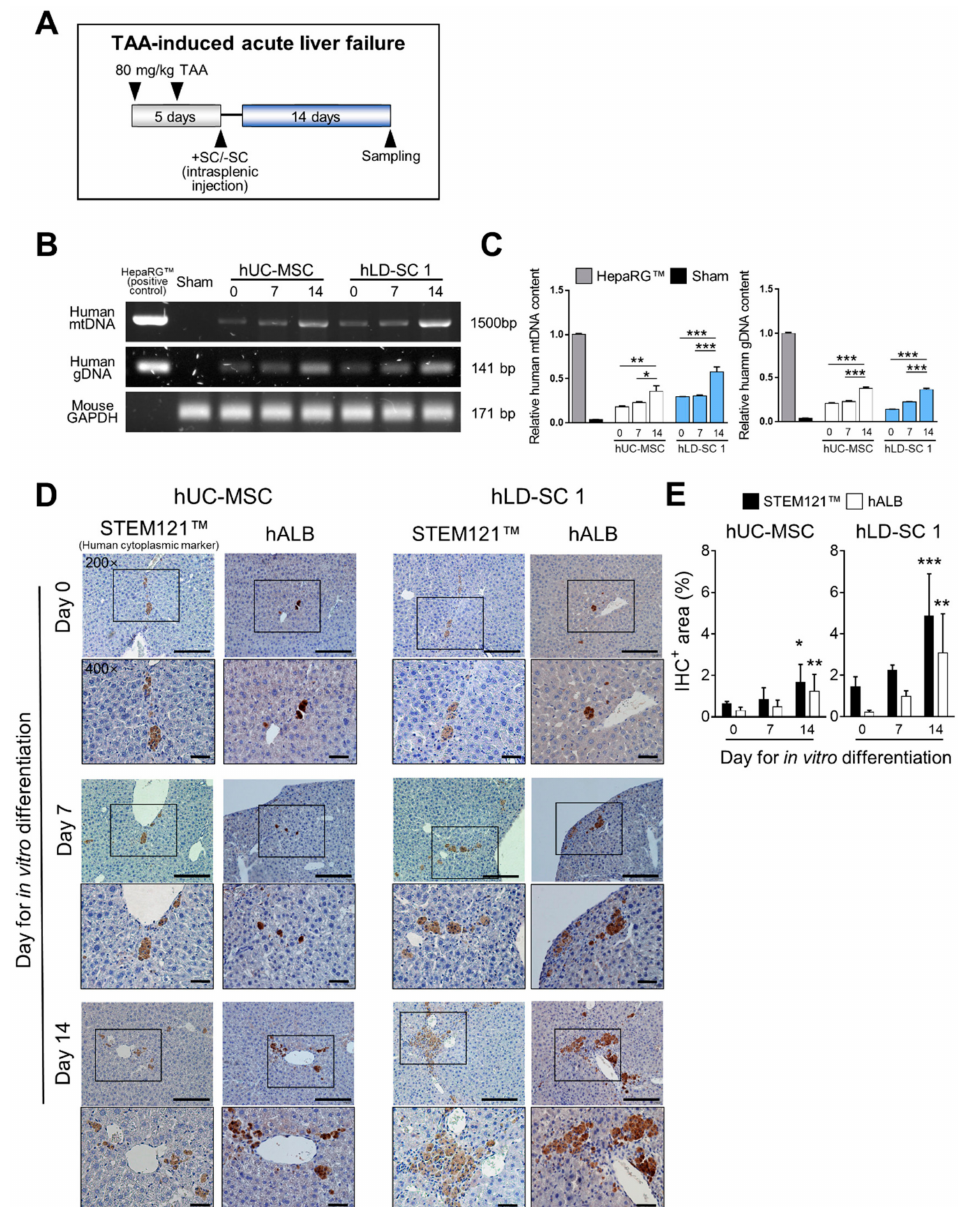
Figure 6. Spontaneous hepatocyte di ff erentiation and maturation in thioacetamide (TAA)-induced acute liver failure mice. ( A ) Schematic diagram of TAA-induced acute liver injury in Rag2 - / - Il2rg - / - (NRG) mice. hUC-MSCs and hLD-SCs on days 0, 7, and 14 of di ff erentiation towards hepatic fate were treated with intrasplenic administration, and mice were restored for 14 days. ( B ) Representative polymerase chain reaction (PCR) results of human mitochondrial DNA (human mtDNA; amplicon size, 1500 bp), human-specific genomic DNA (human gDNA; amplicon size, 141 bp), and mouse genomic GAPDH (Mouse GAPDH ; amplicon size, 171 bp). Total DNA was isolated from para ffi n blocks used for immunohistochemistry (IHC). ( C ) Quantification of the relative human mtDNA and gDNA contents. The contents were compared relative to the amount of mtDNA and gDNA of HepaRG ™ . Total DNA was extracted from 1 × 10 5 HepaRG ™ cells. ( D ) Representative images of human STEM121 ™ (human cytoplasmic marker) and human albumin (hALB) IHC in mice restored 14 days after stem cell transplantation. Scale bar, 100 µ m for 200 × magnification; Scale bar, 50 µ m for 400 × magnification. ( E ) STEM121 ™ and hALB positive area (%) of hUC-MSCs and hLD-SCs are expressed as mean ± standard deviation and each value was compared to day 0. p -values < 0.05 were considered significant. n = 3 for sham; n = 4 for other groups. *, p < 0.05; **, p < 0.01; ***, p <